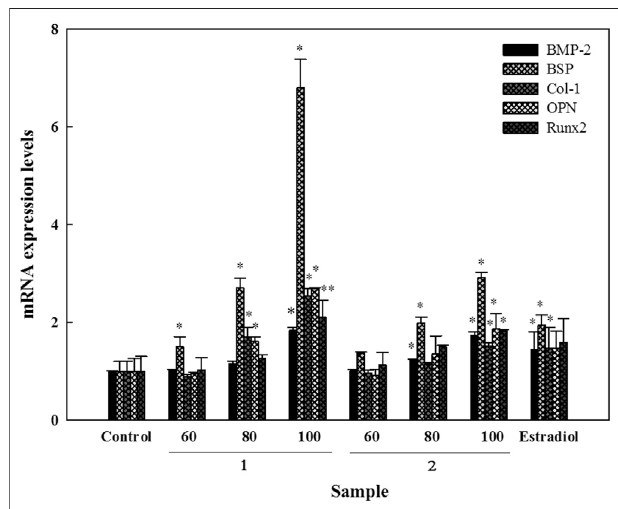
FIGURE 5 | Effects of active compounds on mRNA expression levels of bone formation-related genesin human osteoblast cells. Cells were seeded in 6 cm dishes, and after 24 h, samples were added using fresh osteoblast differentiation medium. Following this, cells were collected for RNA isolation and cDNA generation. mRNA expression levels were detected using a UPL-probe system, and data are depicted as multiples. Experiments were carried out in triplicate. * p < 0.05 and ** p < 0.01; data are presented as the mean ± standard deviation. 1 , astragalin and 2 , kaempferol 3- O